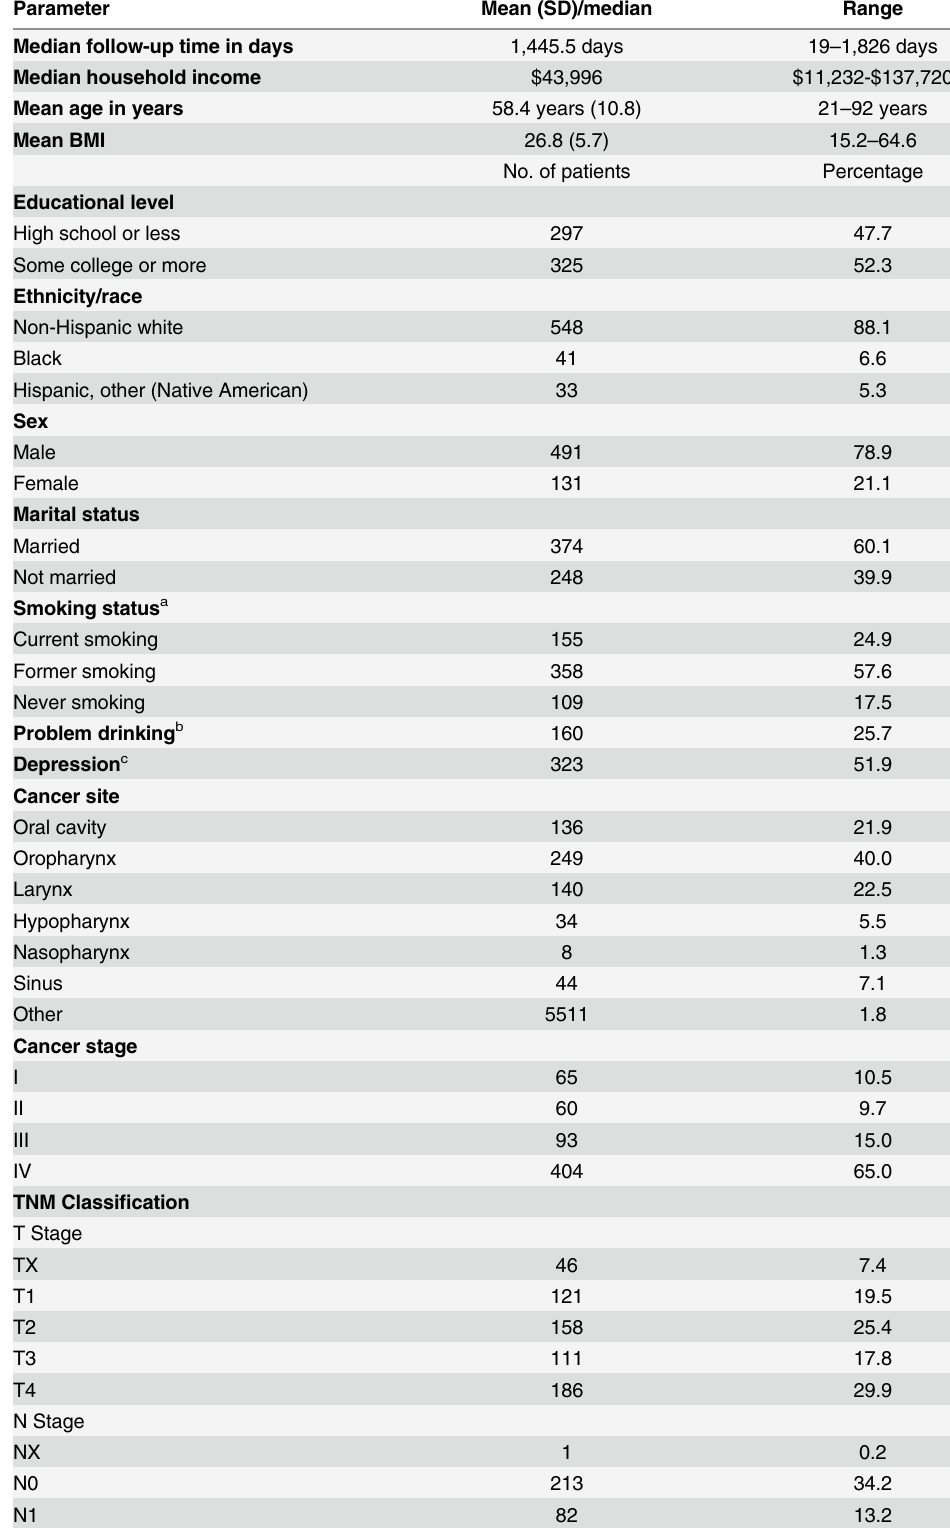
Table 2. Pretreatment patient characteristics of newly diagnosed head and neck cancer patients. (N =